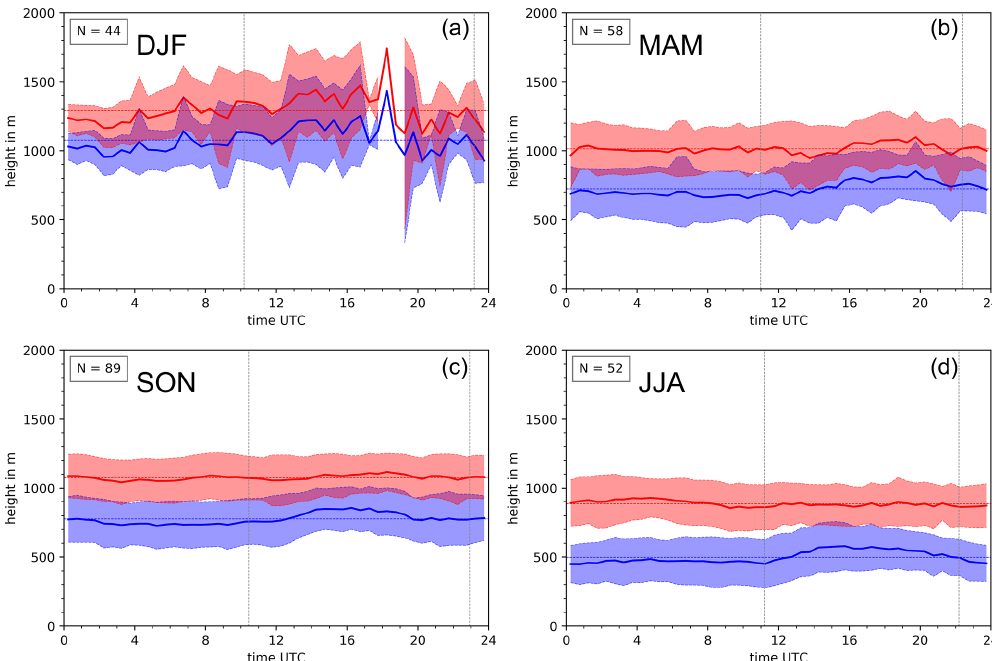
Figure 7. Average diurnal course of the cloud base (blue) and cloud top (red) during different seasons. Clockwise: (a) austral summer (DJF), (b) fall (MAM), (d) winter (JJA) and (c) spring (SON). Color shading indicates the range of 1 standard deviation. The value of N gives the number of days analyzed. Vertical dashed lines indicate the average times of sunrise and sunset.